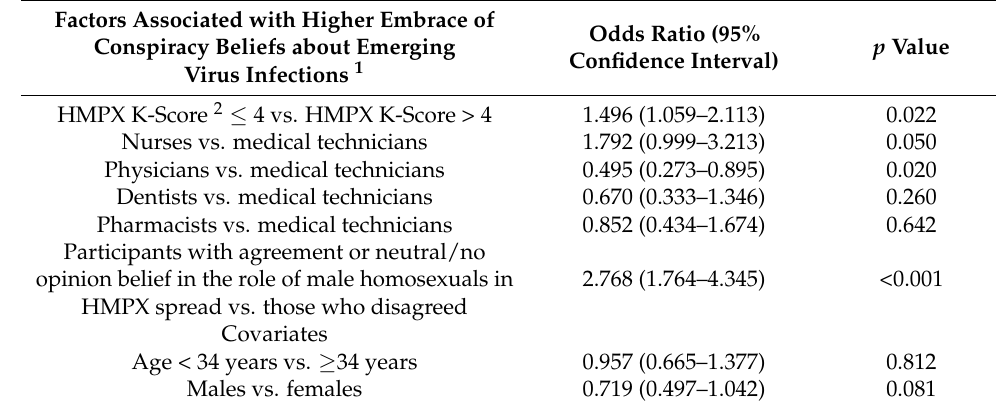
Table 3. Factors correlated with higher endorsement of conspiracy beliefs about emerging virus infections among the study participants ( n =